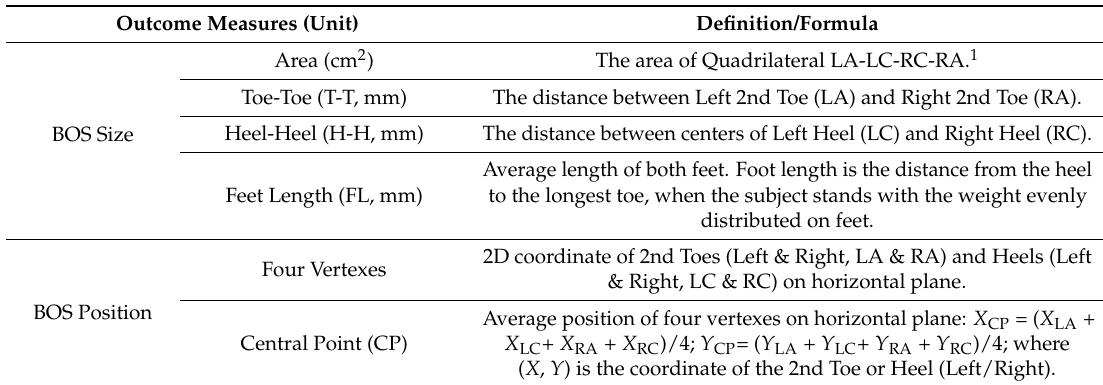
Table 2. Base of Support (BOS) measures from Xsens MVN biomechanical model. Outcome Measures